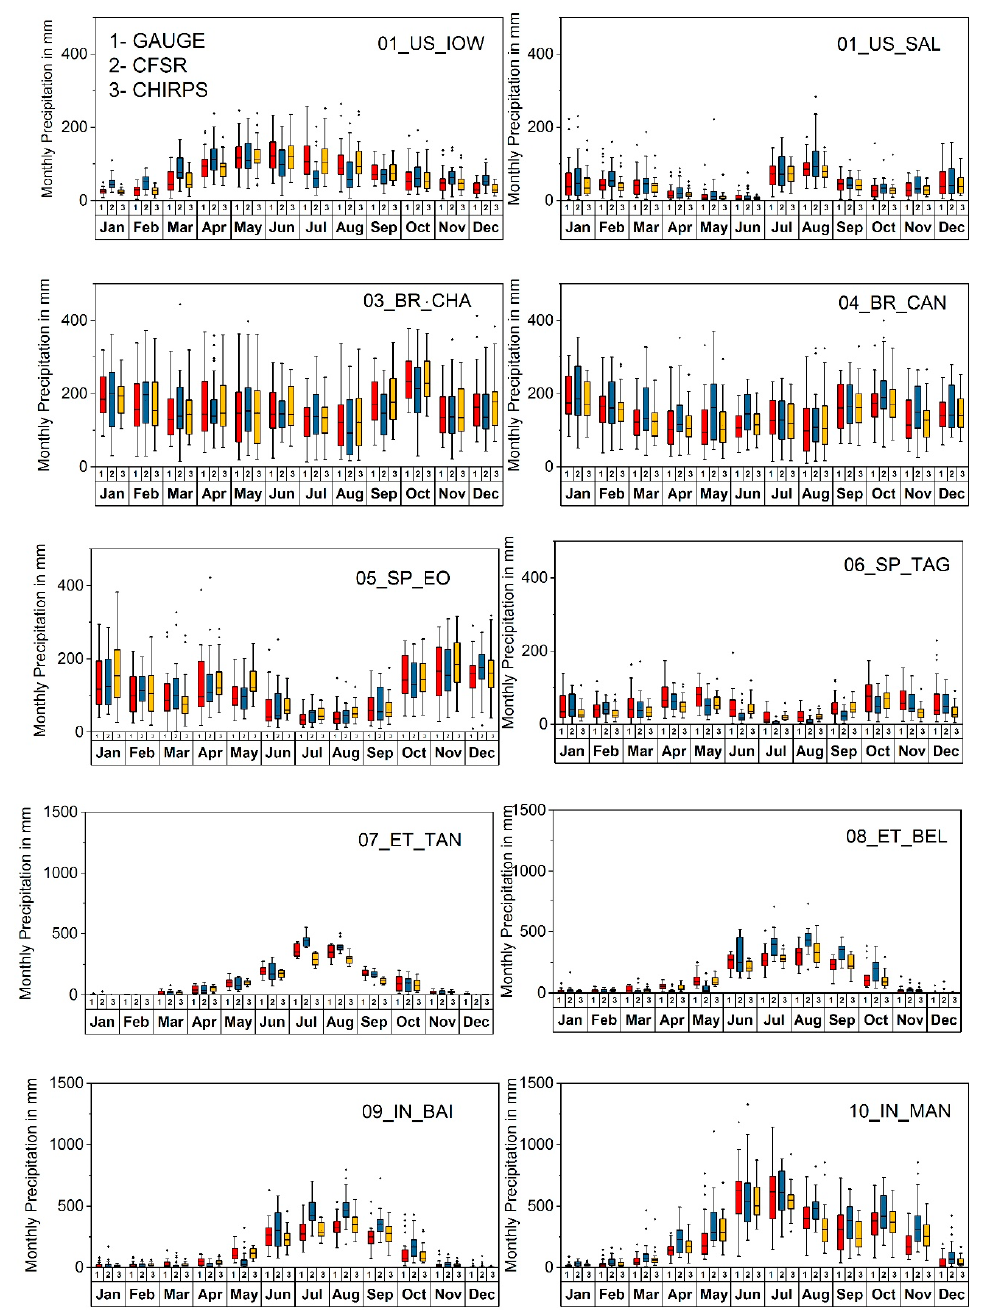
Figure 3. Box plot comparison of the magnitude of rainfall and its temporal distribution generated by 1. Gauge 2. CFSR, and 3. CHIRPS. 1. Gauge 2. CFSR, and 3.